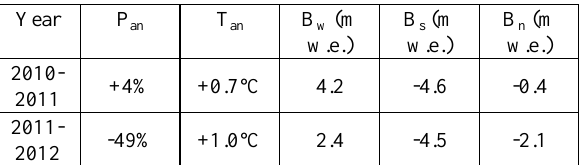
Table 1. Climatic conditions at the weather station of Pontebba (561 m a.s.l., reference period 1981-2010) and mass balance observation on the Montasio Occidentale glacier. P an = precipitation anomaly in the accumulation season (November to April); T an = temperature anomaly in the ablation season (May Figure 4. Spatial distribution of elevation changes and shrinking to October); B w = winter balance, B s = summer balance; B n = of the firn-covered area in the 2011-'12 hydrological year. annual net balance. Asterisks indicate collapse structures, circles indicate ridge- shaped